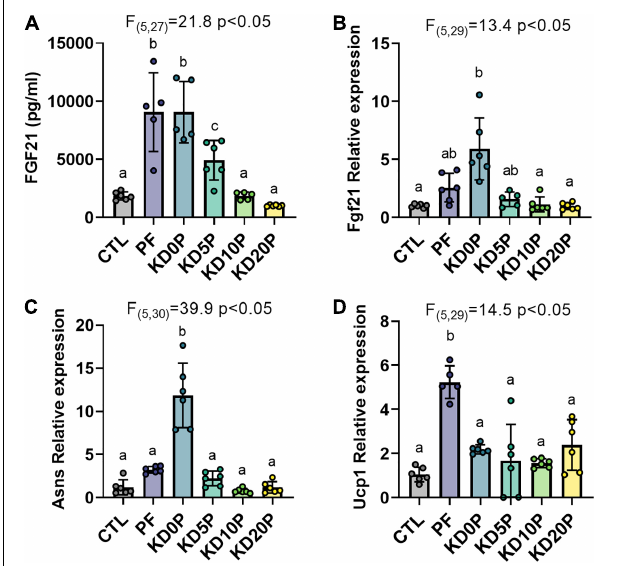
FIGURE 3 | Protein-free, but not ketogenic, diets induce molecular markers of dietary protein restriction. (A) Serum FGF21 was measured in 6-h fasted mice fed experimental diets for 8 days. Liver gene expression of Fgf21 (B) and Asns (C) and brown adipose tissue expression of Ucp1 (D) were measured by RT-qPCR and normalized to actin expression. Statistical analysis was performed by one-way ANOVA with Tukey’s multiple comparison test. Different letters indicate significant differences ( p < 0.05) between groups, with common letters indicating no significant difference. Values are represented as mean ±